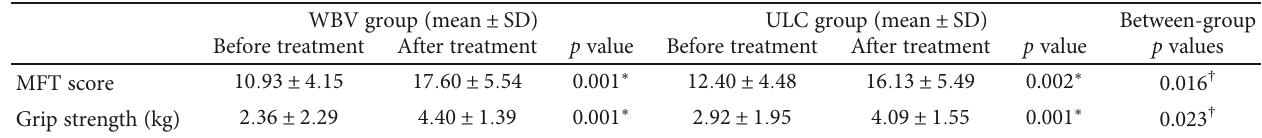
Table 2: Parameters before and after